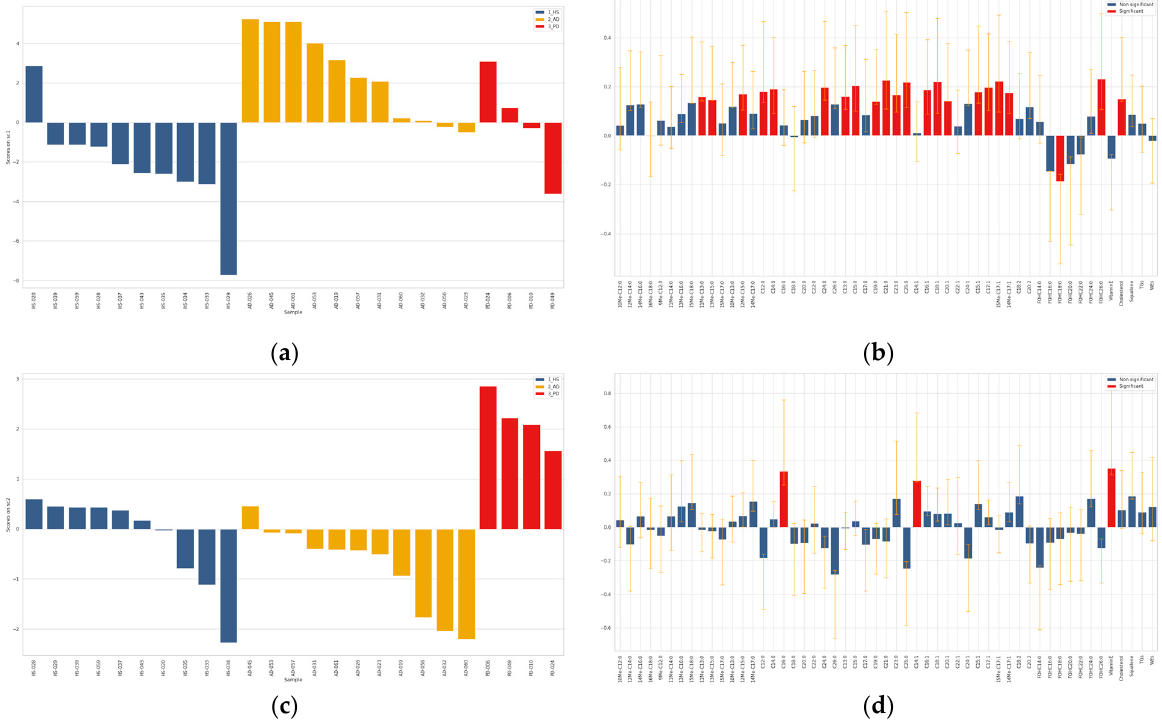
Figure 2. ASCA analysis on the effect matrix (absolute amounts, µg) for NDD conditions investigated in sebum from female (F) subjects. Panels ( a , c ) report the SC1 and SC2 scores, respectively, after projection of the residuals onto the space spanned by the significant principal component (PC) 1 and PC2; legend: blue = HS; yellow = AD; red = PD. Panels ( b , d ) display the variable loadings on SC1 and SC2, respectively, together with their confidence interval (red and blue bars indicate significantly and not significantly contributing descriptors, respectively).